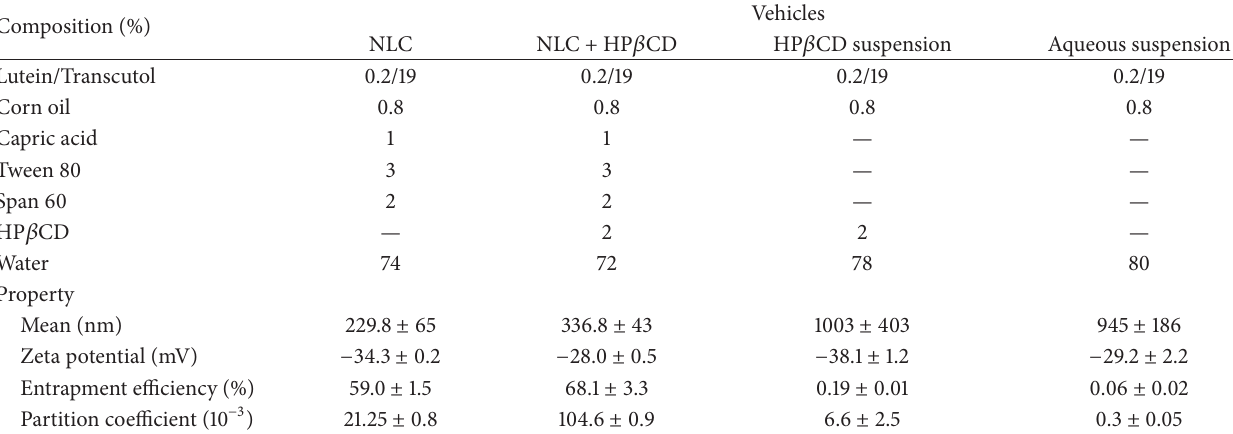
Table 3: Composition and characteristics of vehicles loaded with lutein ∗